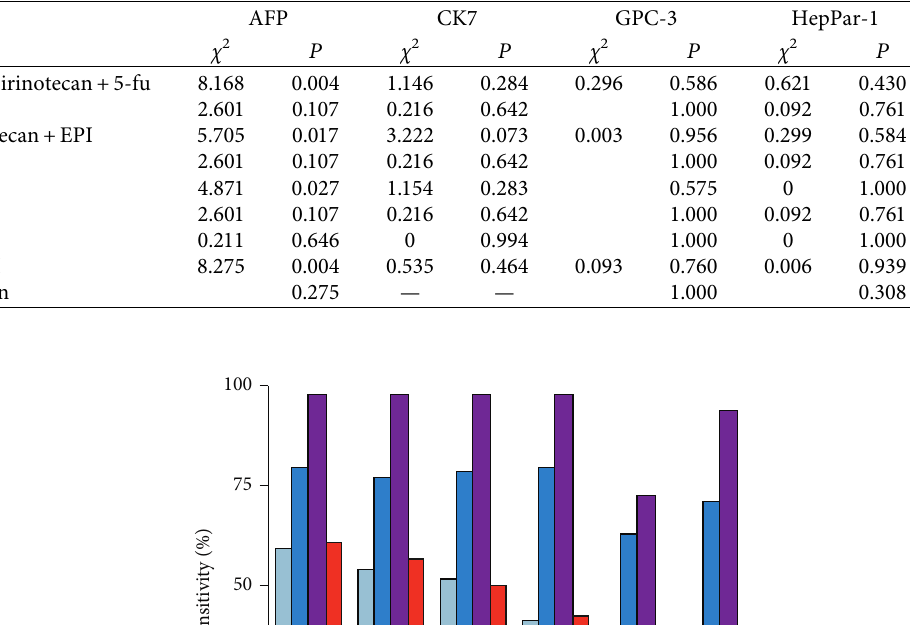
Table 6: Relationships between immunohistochemistry markers and sensitivity to combination regimens.